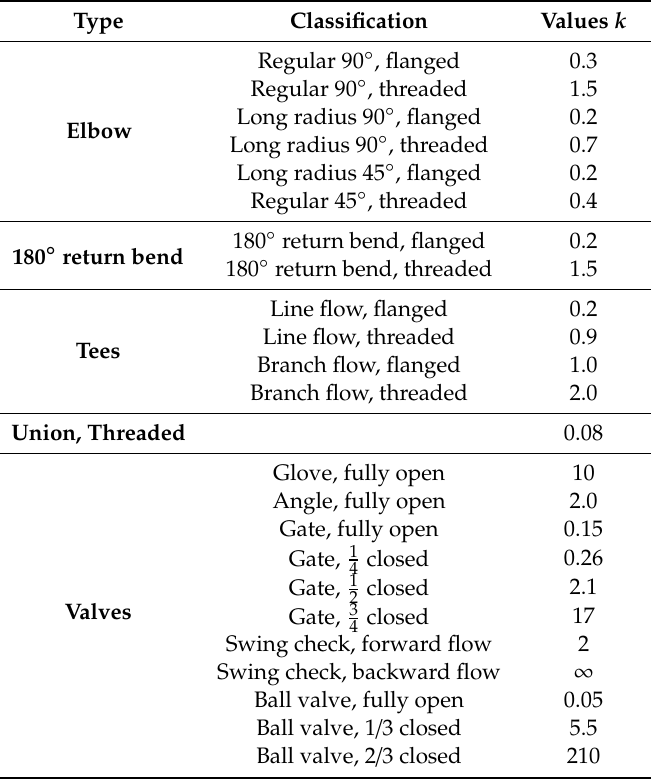
Table 1. Typical local loss coe ffi cient k